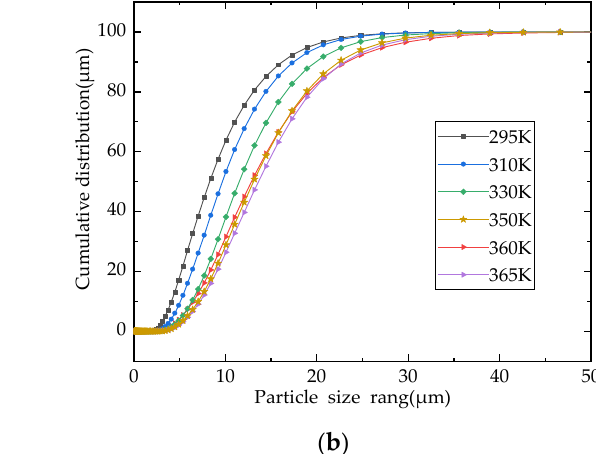
Figure 8. Particle size distribution at different temperatures: ( a ) particle size range; ( b ) cumulative distribution range.